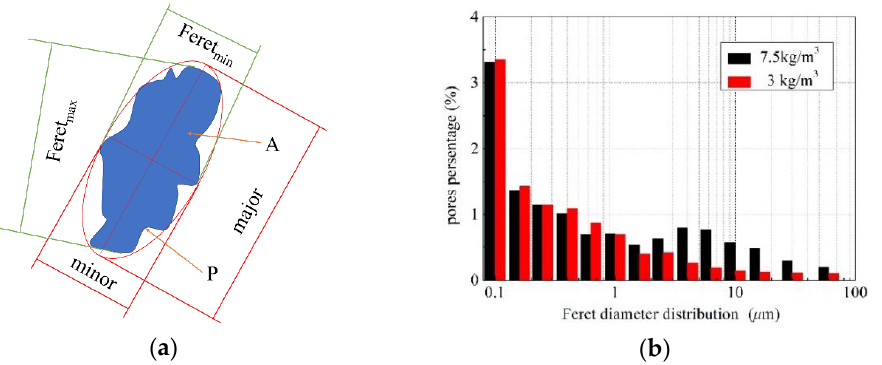
Figure 13. Schematic diagram of pore geometry and distribution diagram of Feret diameter. ( a ) pore geometry; ( b ) distribution of Feret diameter.